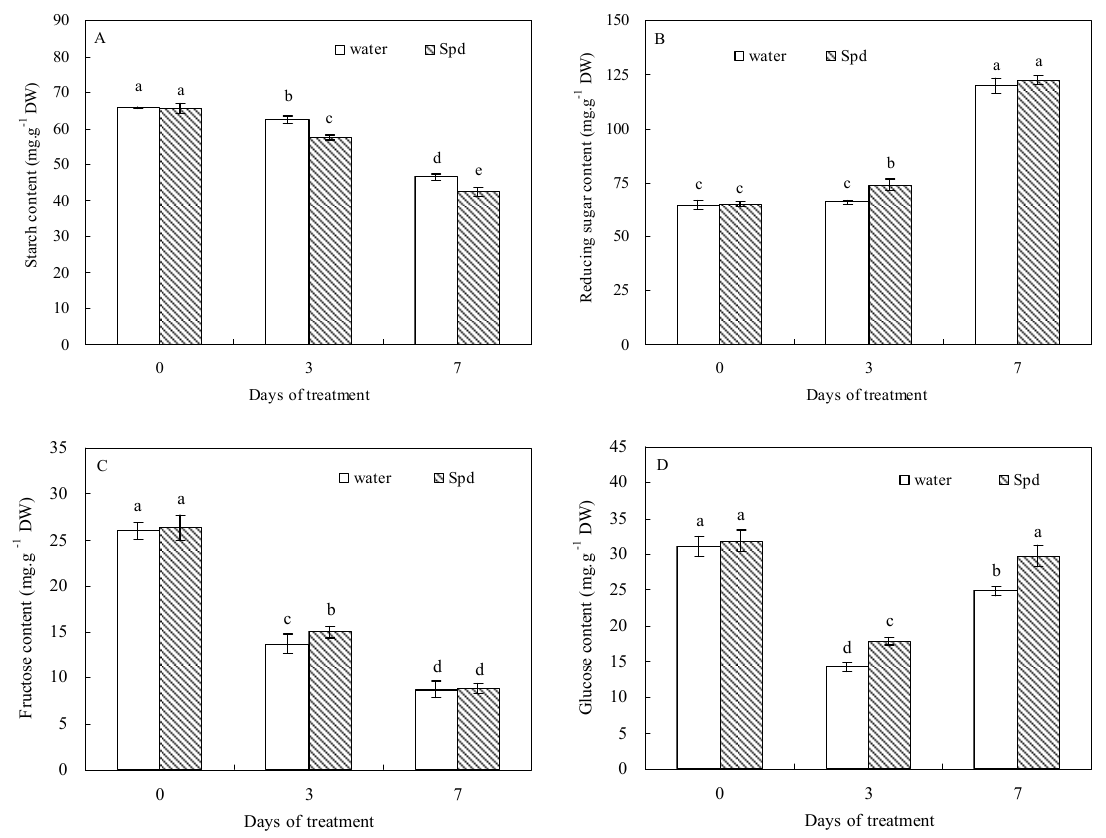
Figure 1. The effect of seed soaking with water or spermidine (Spd) on ( A ) starch content; ( B ) reducing sugar content; ( C ) fructose content and ( D ) glucose content in the process of seeds germination (7 days) under water stress induced by 15% PEG. Vertical bars indicate ± SE of mean ( n = 6). Different letters above columns indicate significant difference. LSD ( p ≤